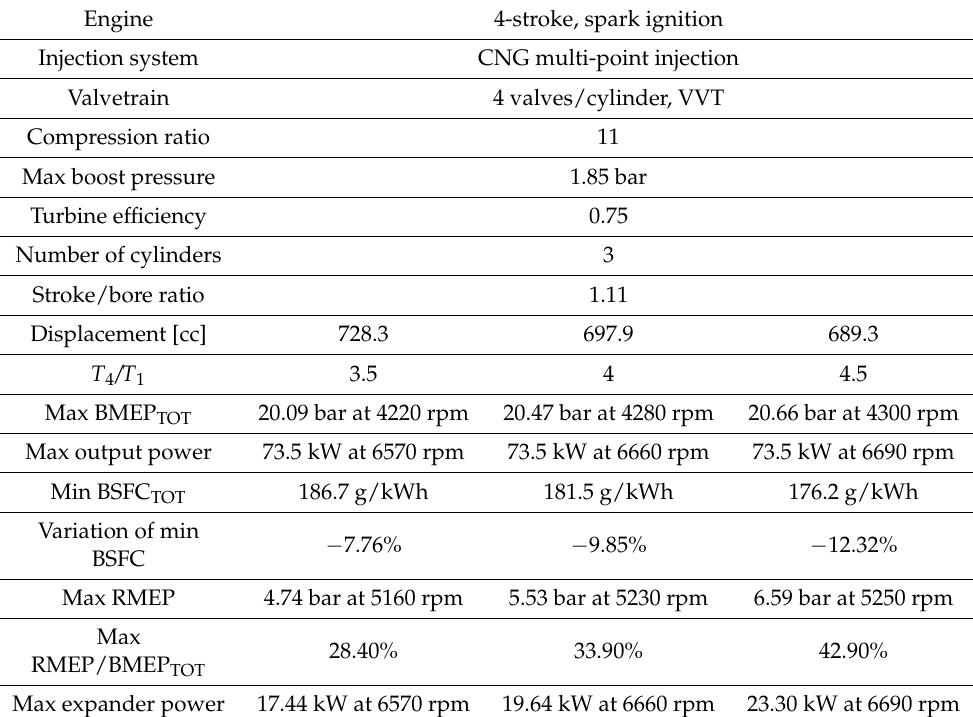
Table 8. Main characteristic of the compound engine obtained with η T =